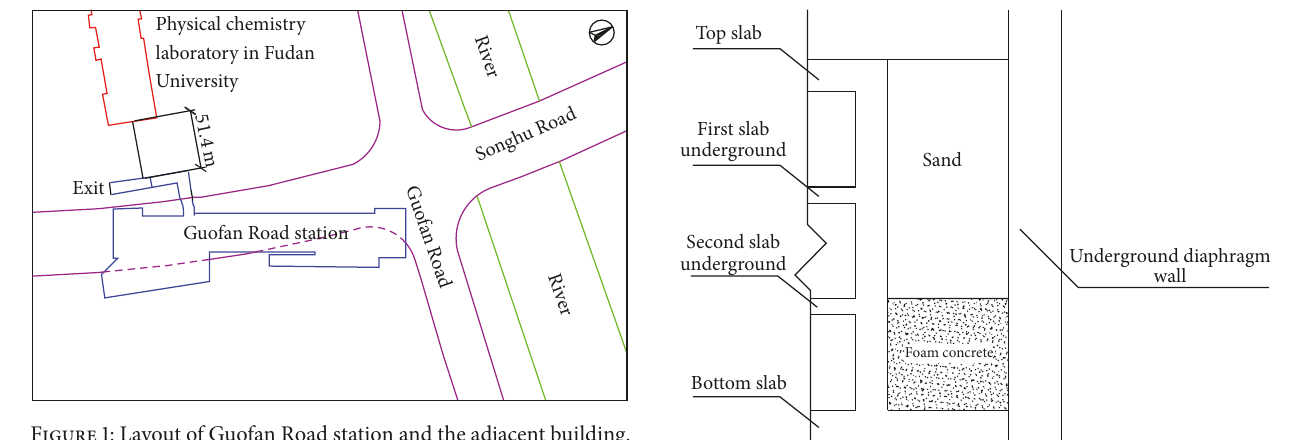
Figure 1: Layout of Guofan Road station and the adjacent building.